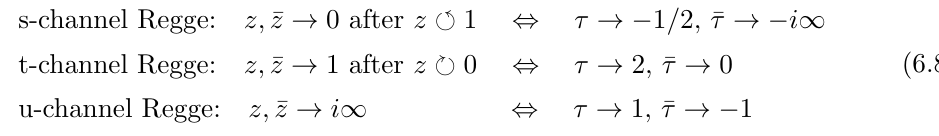
(cid:21) ( (cid:28) ). The image of the interior of the 7! ; 0] and [1 ; ). The four (cid:0)1 1